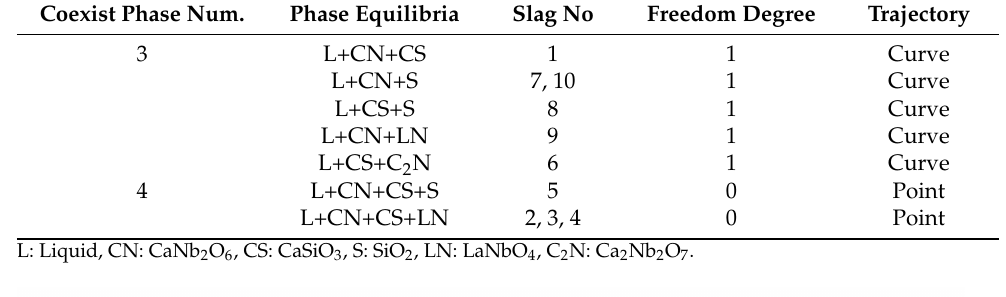
Table 4. Summary of high temperature equilibrium experiment results. Coexist Phase Num.